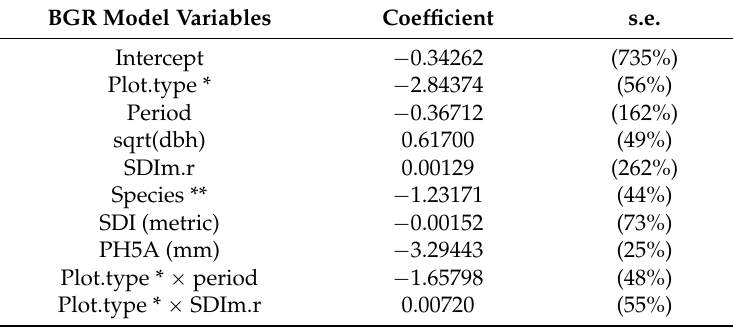
Table 4. Branch growth response (BGR) model for Mendocino County,